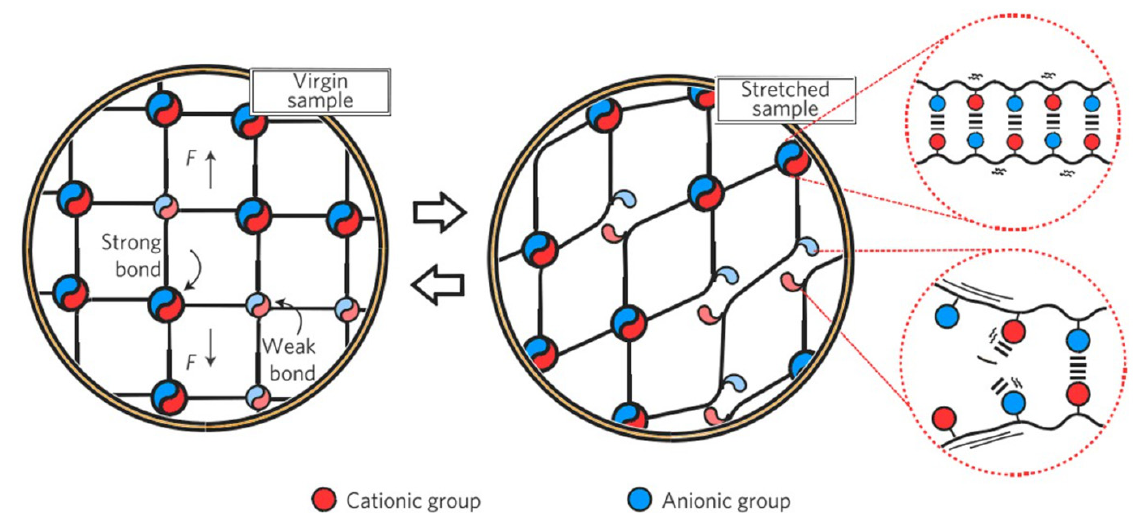
Figure 5. Schematic diagram of PA gel network containing ionic bonds of different strengths [93].